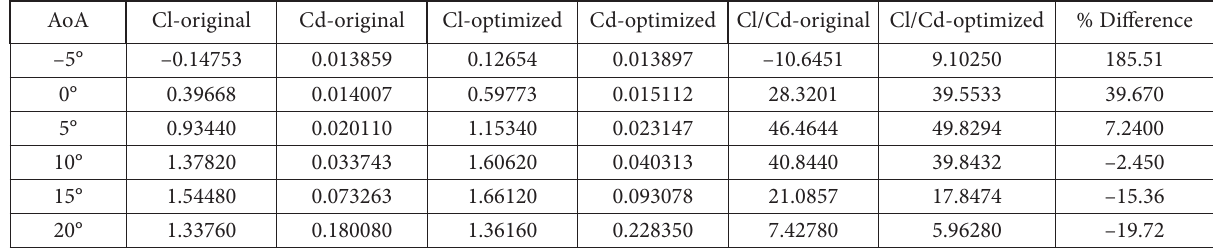
Table 4. ANSYS Fluent simulation